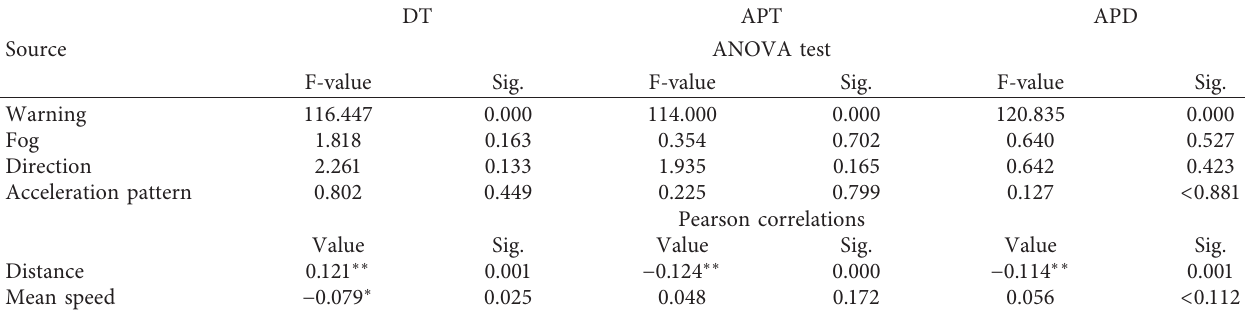
Table 2: ANOVA and the Pearson correlation results of DT, APT, and APD.